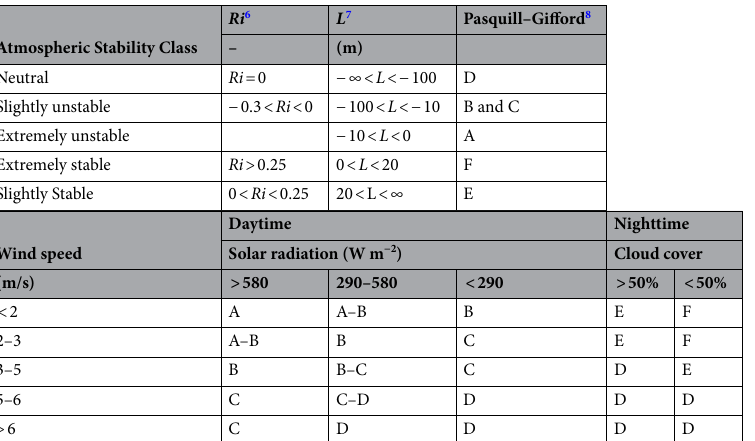
Table 1. Parameters used to describe atmospheric stability conditions. Richardson number Ri = g ρ ∂ρ/∂ z Monin–Obukhov Length L